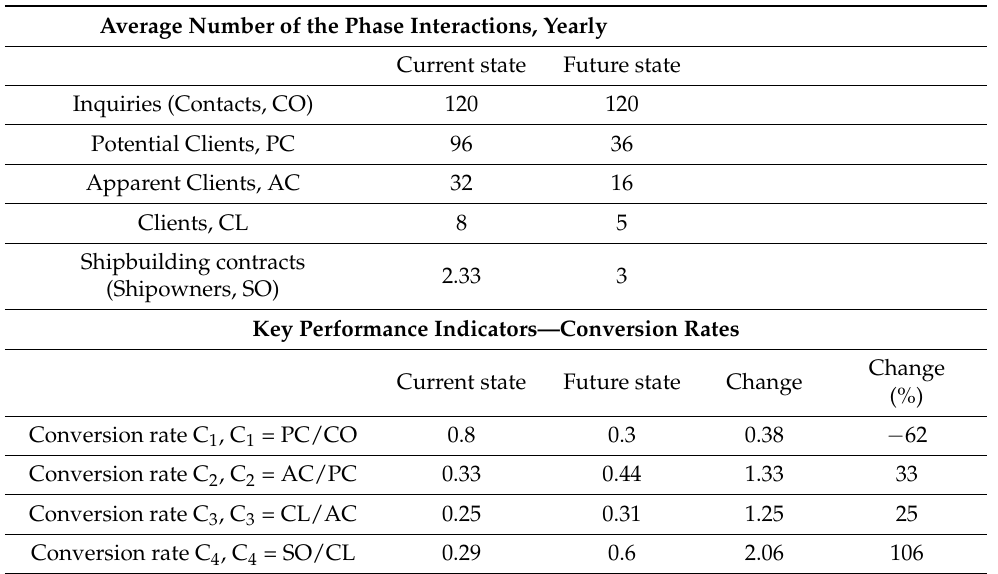
Table 4. Key performance indicators—conversion